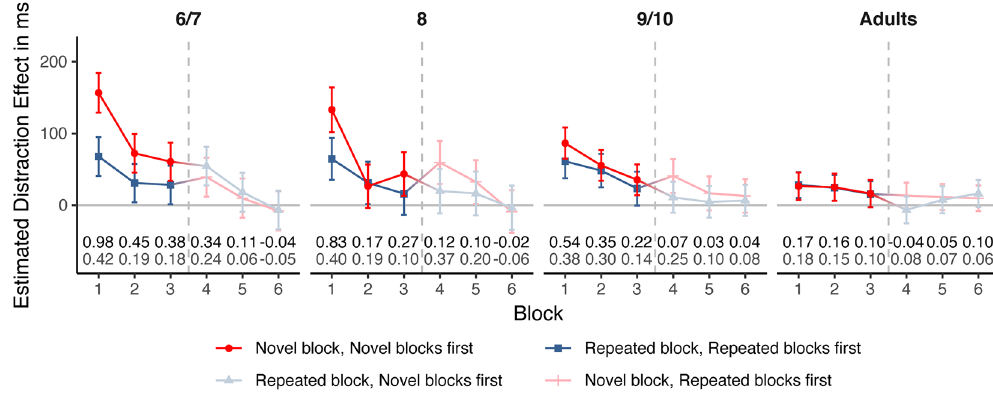
(cid:31) (cid:31) (cid:31) RT = RT distractor − RT standard ) from the block effect (cid:31) RT (cid:31) RT distractor − standard for z -standardized